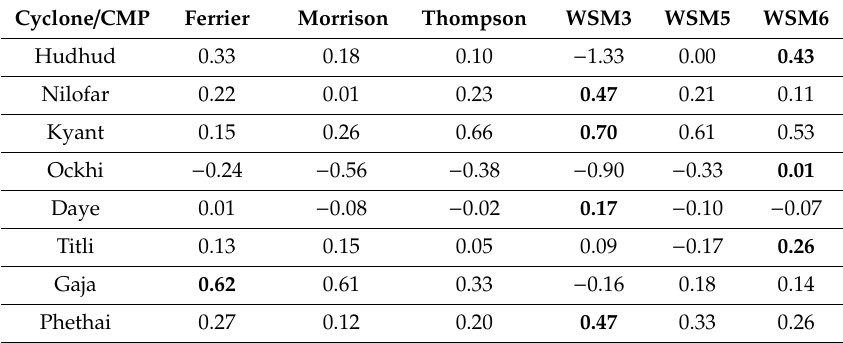
Table 5. Skill score for maximum sustained wind (MSW).